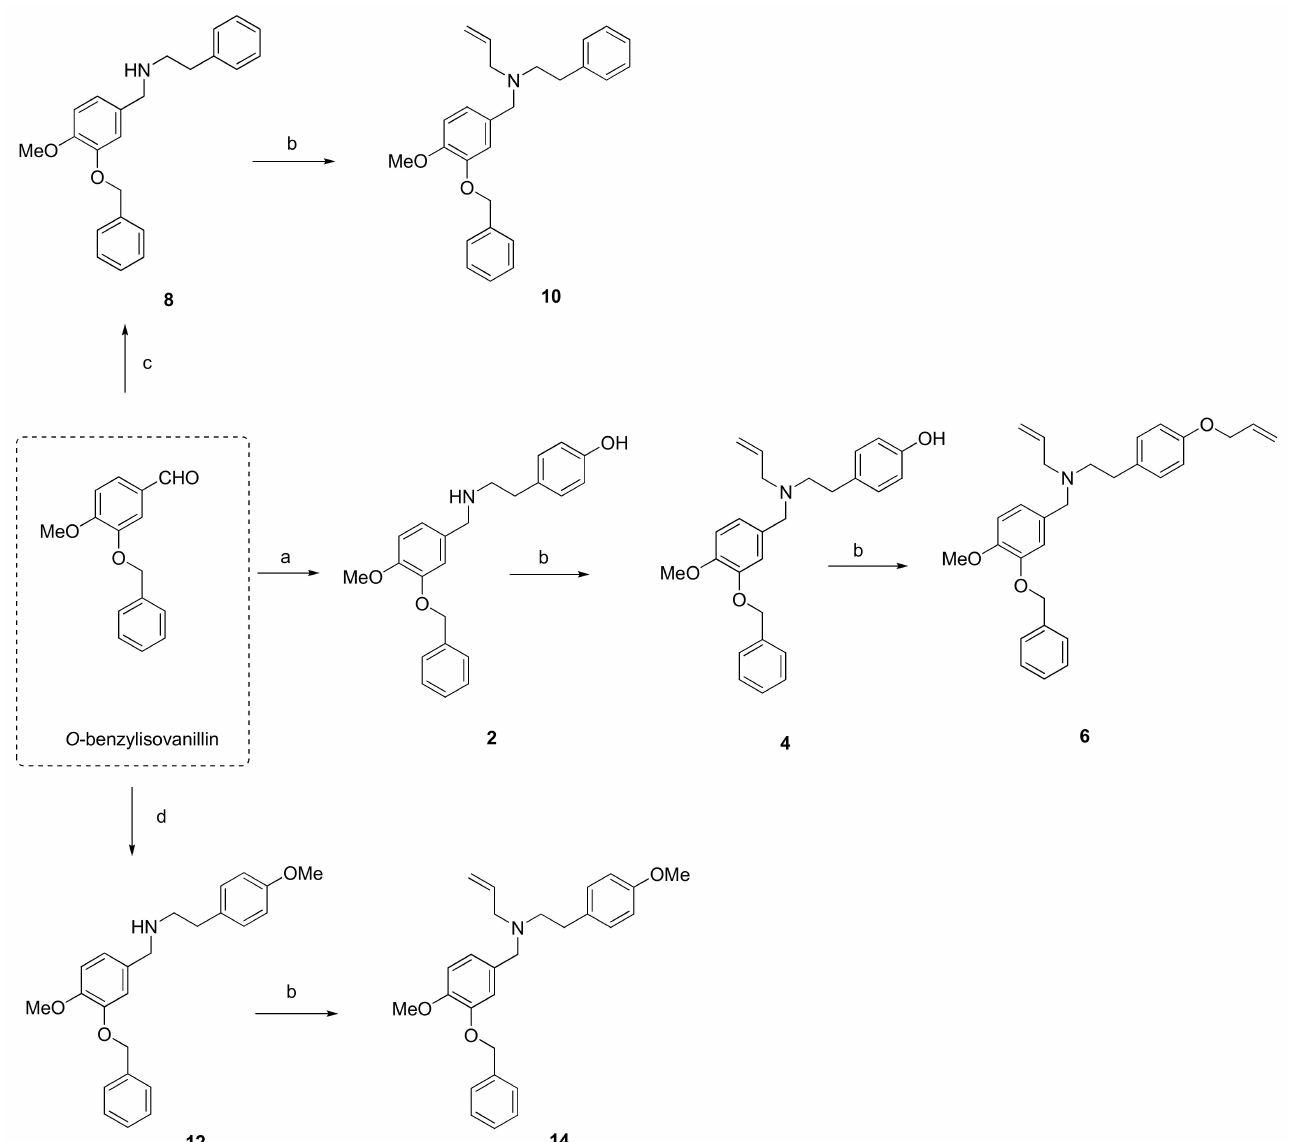
Scheme 2. Synthesis of novel h BuChE inhibitors 2 , 4 , 6 , 8 , 10 , 12 and 14 starting from O- benzylisovanillin. Reagents